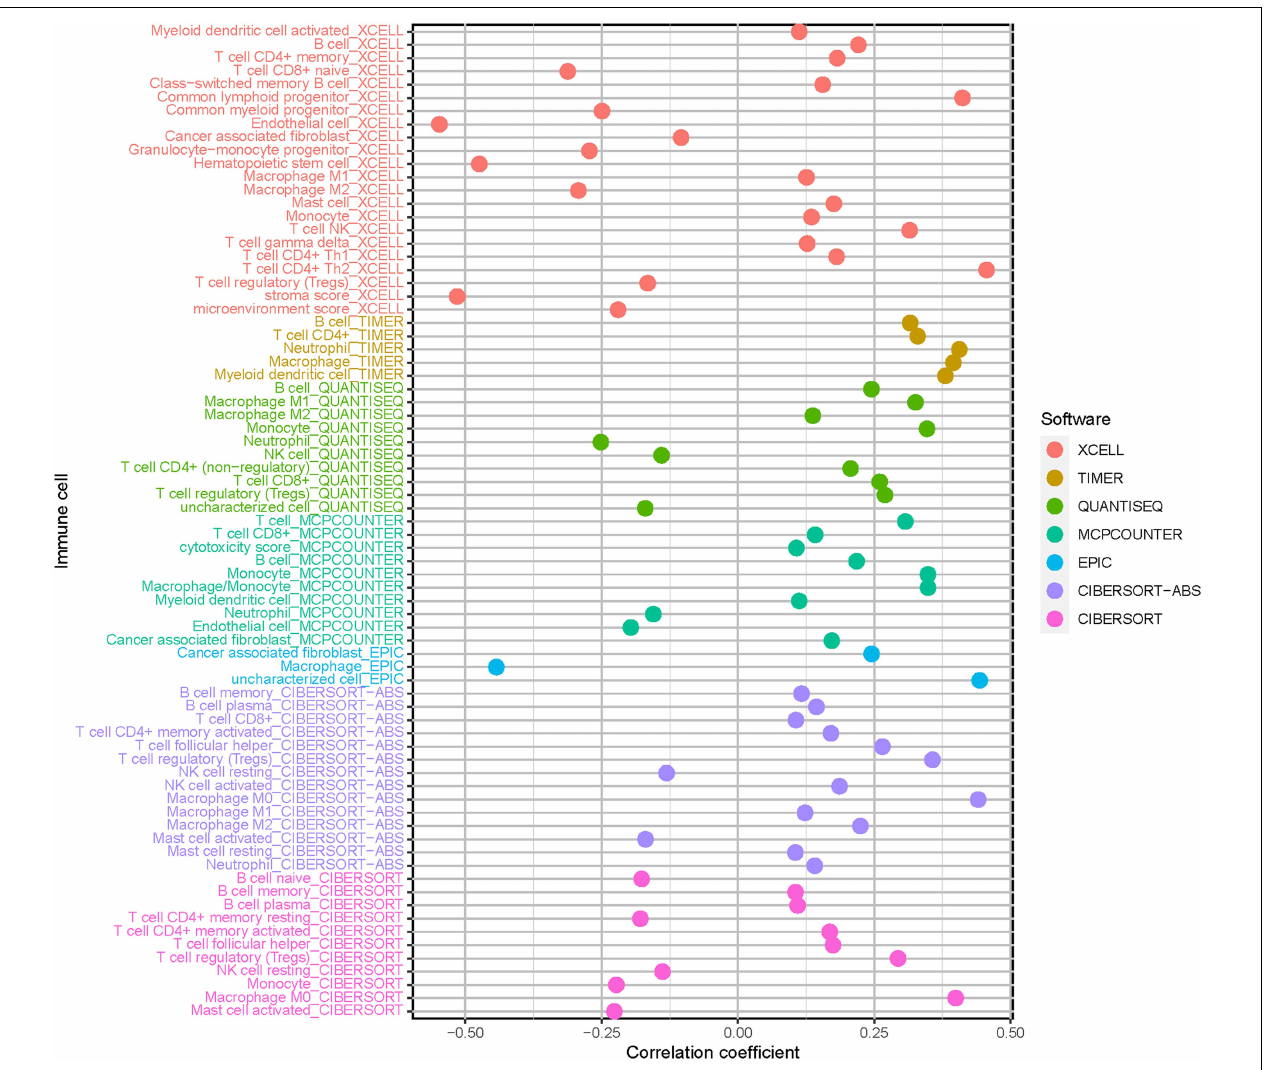
FIGURE 6 | Estimation of tumor-infiltrating cells under risk score in HCC. Patients in the high-risk group were more positively associated with tumor-infiltrating immune cells, as shown by Spearman correlation